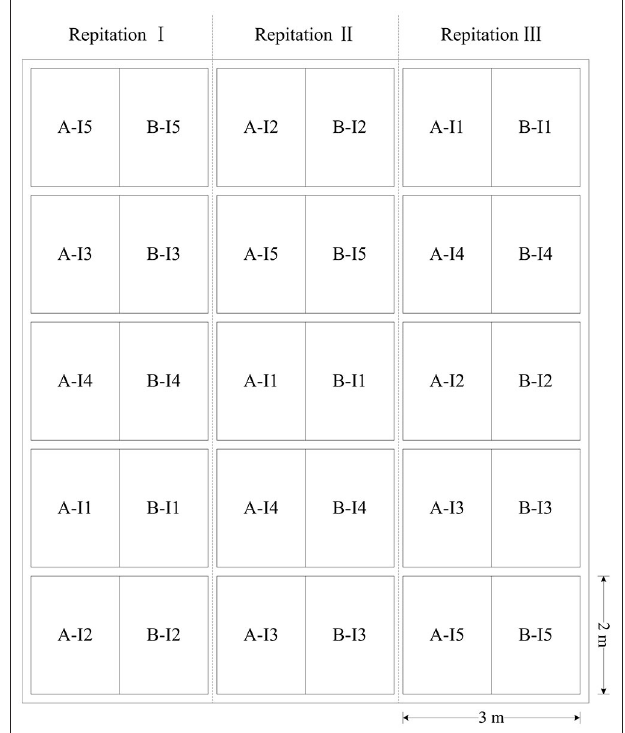
FIGURE 1 | The distribution map of the different treatments of irrigation regimes applied in the study. I 1 represents four irrigations at jointing, booting, flowering, and filling stage. I 2 represents three irrigations at jointing, booting, and filling stage. I 3 represents two irrigations at jointing and flowering stage. I 4 represents two irrigations at jointing and filling stage. I 5 represents the treatment without irrigation. In 2015–2016, A and B represent Chang 4738 and Zhongmai 175, whereas in 2016–2017 both A and B represent Jingdong